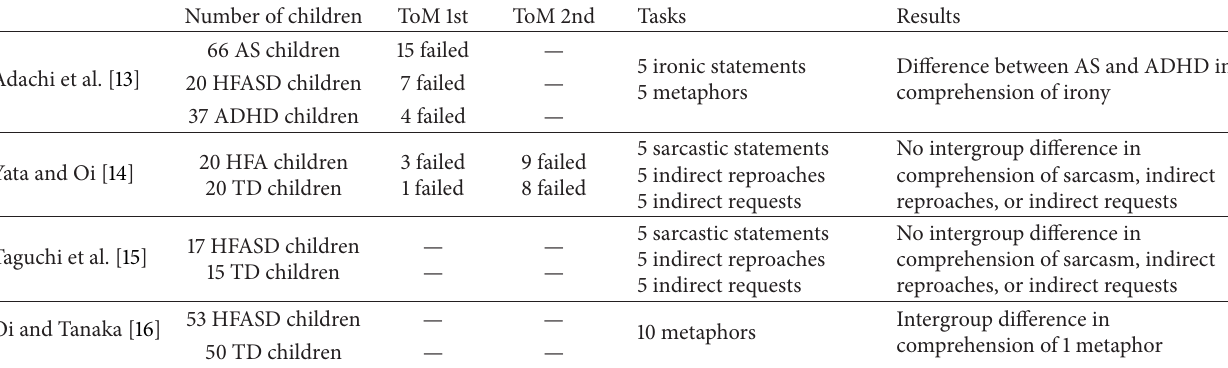
Table 1: Summary of the studies by Adachi et al. [13], Yata and Oi [14], Taguchi et al. [15], and Oi and Tanaka [16]. Number of children ToM 1st ToM 2nd Tasks Results Adachi et al.